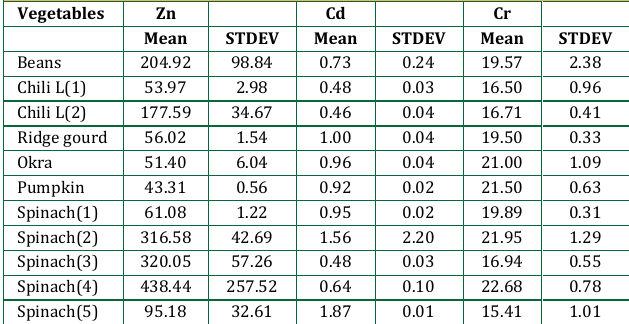
Table 3: Average Concentration of metals in wastewater from Site A, B, C and D Sr. No